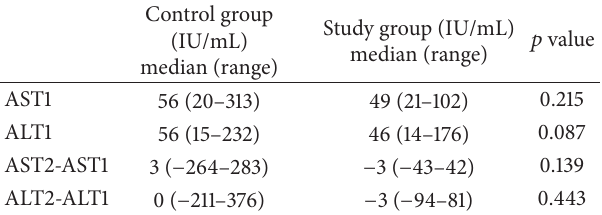
Table 2: The comparison of baseline and the change of ASL/ALT